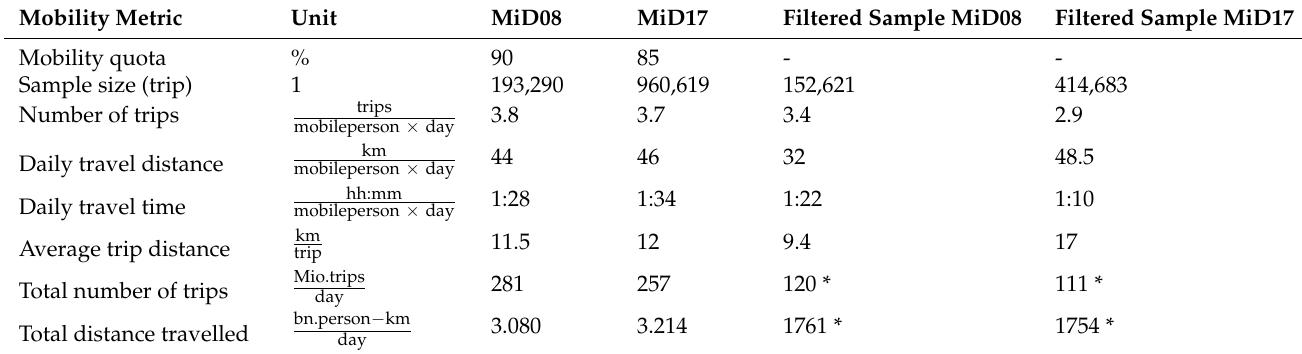
Table 4. Aggregate mobility metrics of the original datasets (only motorized trips) and the filtered